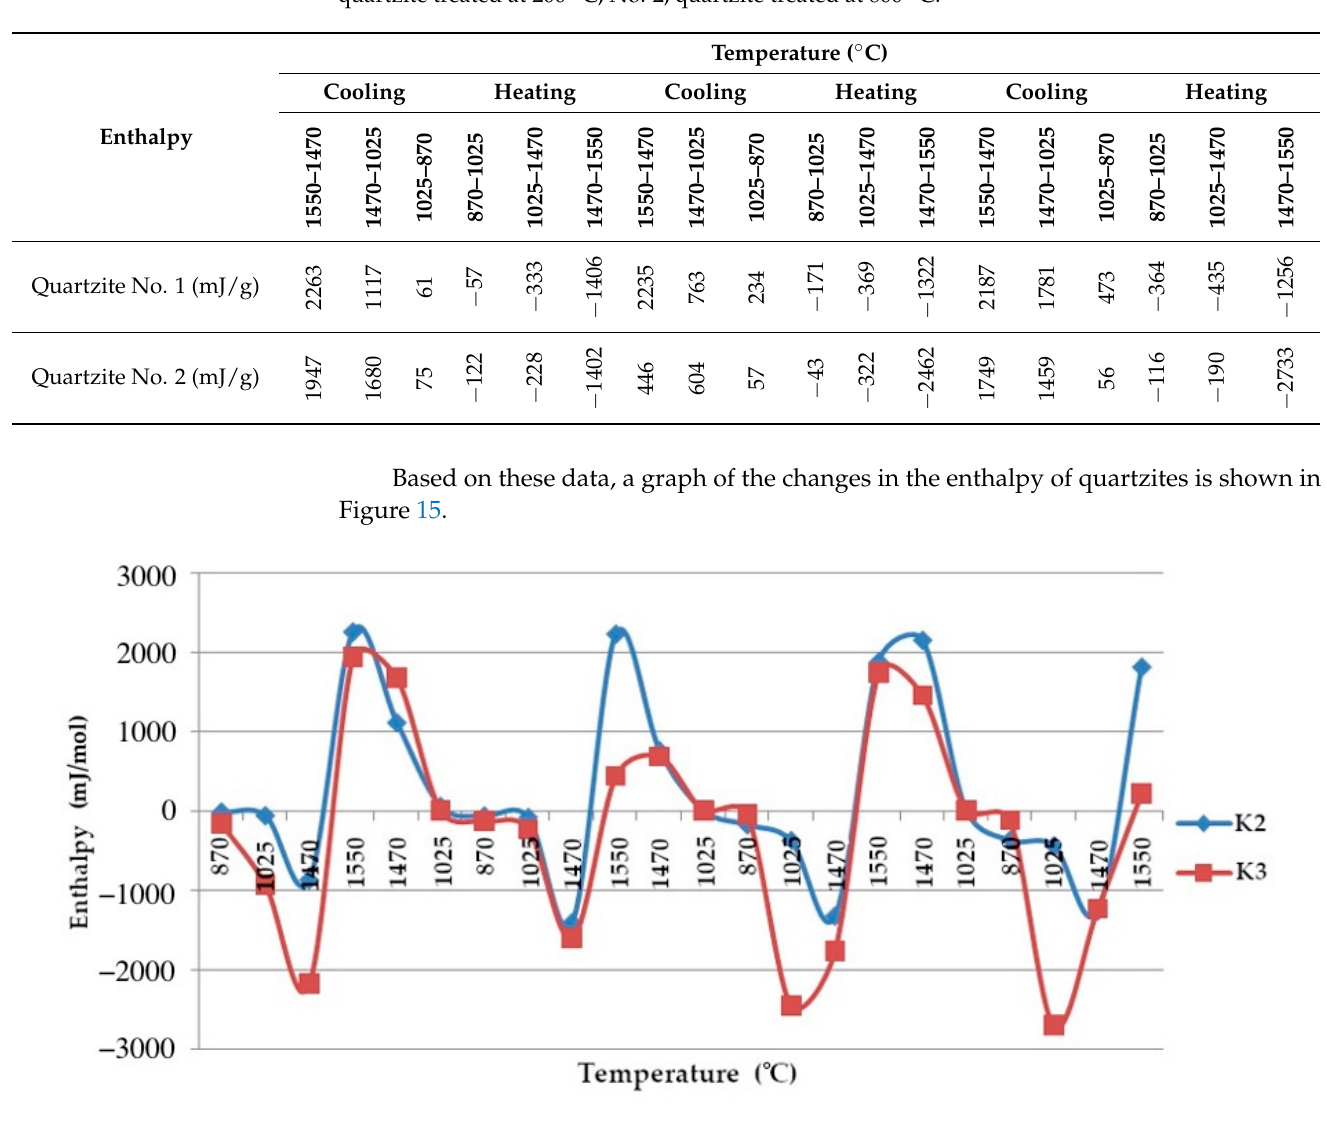
Figure 15. The enthalpy–temperature graph. —Quartzite treated at a temperature of 800 ° С ; — quartzite treated at a temperature of 200 ° С .